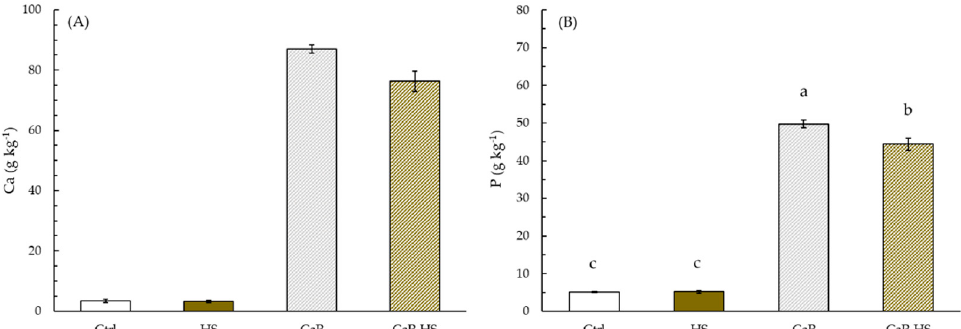
Figure 7. Concentration of Ca ( A ) and P ( B ) in roots of Valerianella locusta . Data are mean ± standard deviation (n = 4). When the interaction between experimental factors (CaP × HS) was significant at ANOVA, different letters were used to indicate statistically significant differences between treatments at Tukey’s post-hoc test ( p ≤ 0.05).